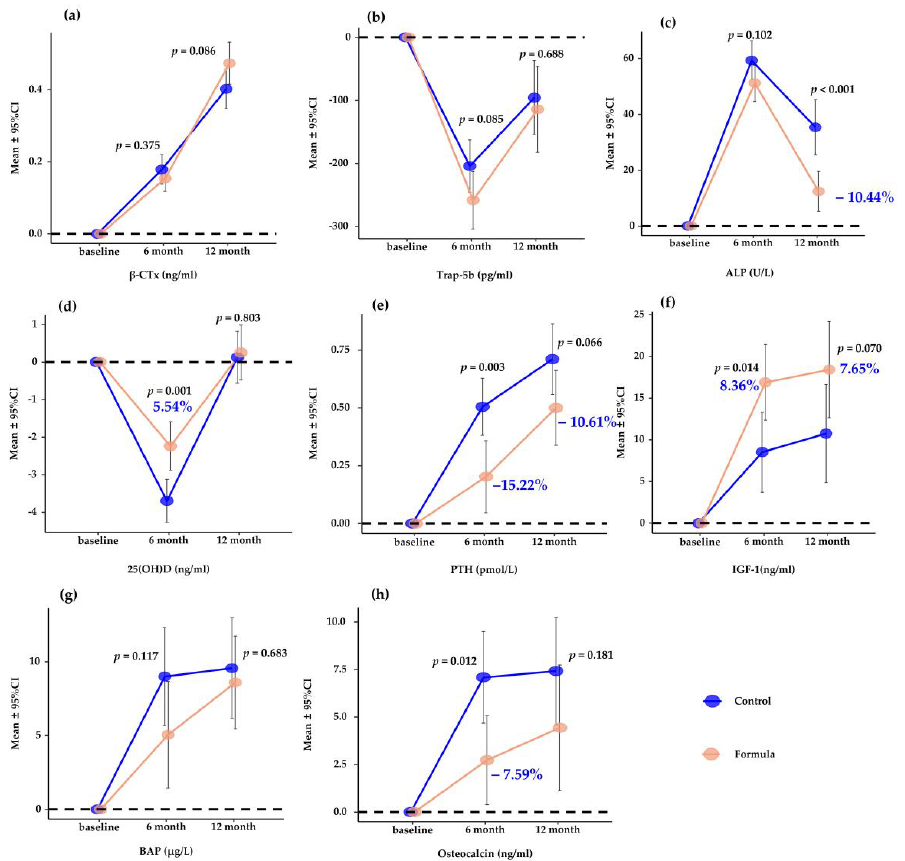
Figure 4. Mean (95%CI) change in bone metabolism biomarkers over 6 and 12 months compared to baseline. ( a – h ) mean (95%CI) changes in β -CTx ( a ), Trap-5b ( b ), ALP ( c ), 25(OH)D ( d ), PTH ( e ), IGF-1 ( f ), BAP ( g ), and osteocalcin ( h ), respectively. p values are for the differences between groups by Student’s t -test. Percentages are incremental gains of bone metabolism biomarkers. β -CTx, β -C-terminal telopeptides; Trap-5b, tartrate-resistant acid phosphatase-5b; ALP, alkaline phosphatase; 25(OH)D, 25-hydroxy-vitamin-D; PTH, parathyroid hormone; IGF-1, insulin-like growth factor 1; BAP, bone-specific alkaline